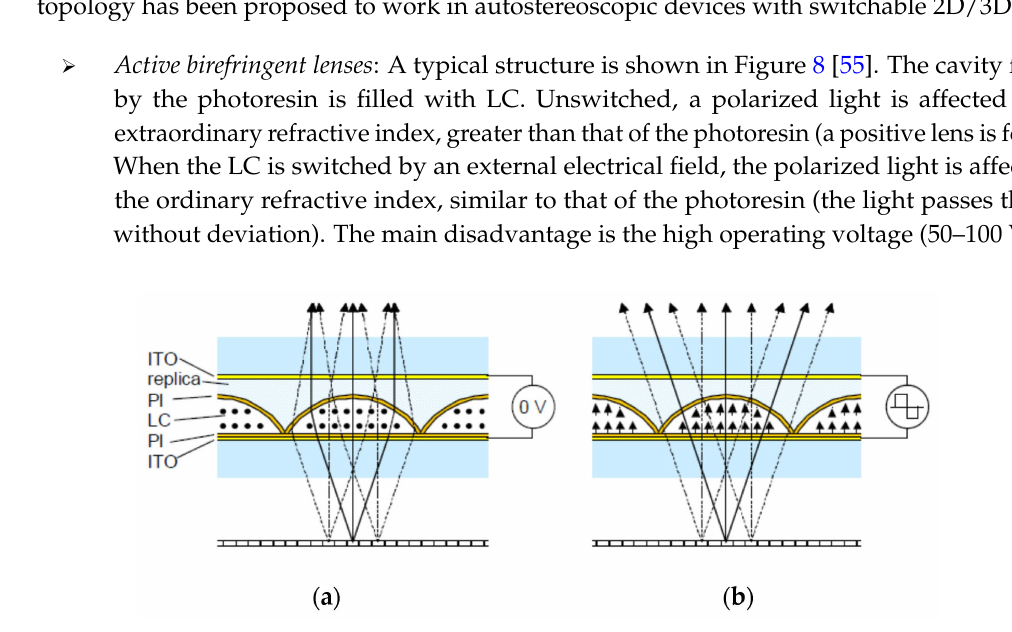
Figure 7. Multilayer liquid crystal lens [53]. Reprinted with permission from Wang, B.; Ye, M.; Sato, S. Applied Optics; published by OSA Publishing, 2004.